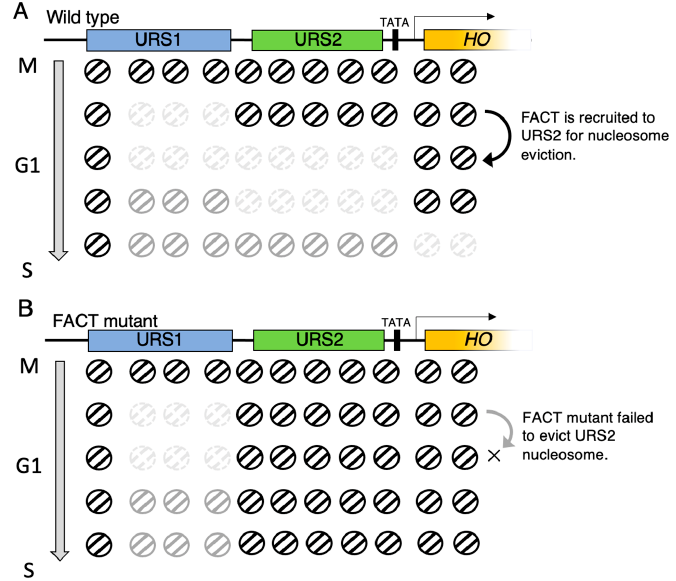
Figure 4. Wave of nucleosome deposition and reposition at the HO promoter during cell cycle progression. Based on GALp::CDC20 arrest/release experiment, nucleosome dynamics were analyzed by time-course histone H3 ChIP-qPCR during M to S phase transition. URS1: upstream regulatory sequence 1, URS2: upstream regulatory sequence 2. ( A ) Schematic representation of nucleosome dynamics along the HO promoter in wildtype cells. ( B ) Schematic representation of nucleosome dynamics along the HO promoter in FACT mutant